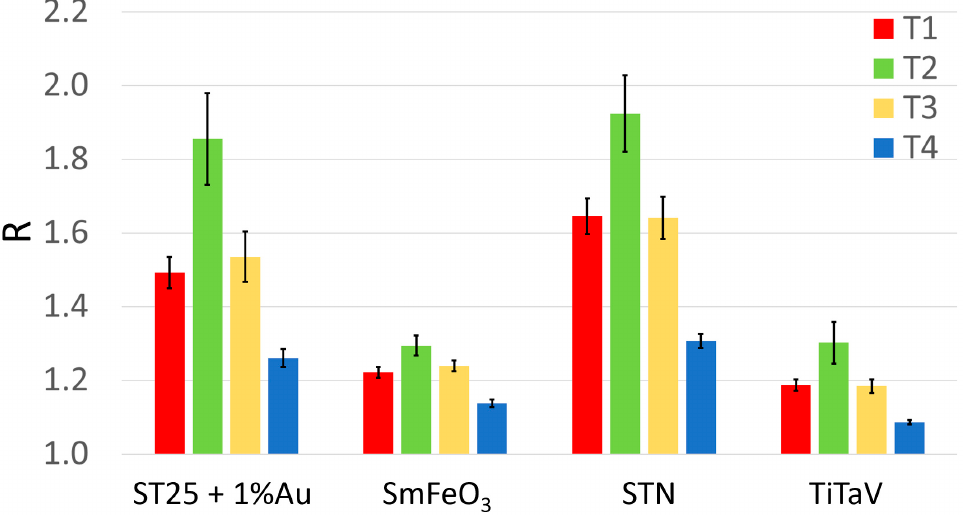
Table 2. Average responses R ± their standard error of the four sensors to TI, T2, T3 and T4 of Figure 3.